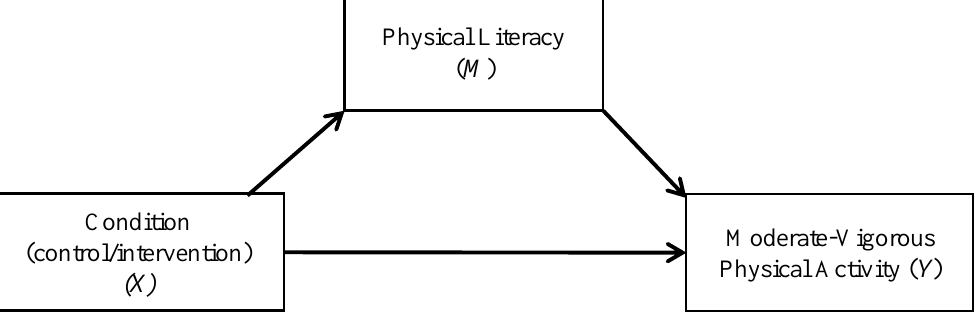
Figure 1 . Condition—moderate–vigorous physical activity single mediation model. Figure 1. Condition—moderate–vigorous physical activity single mediation